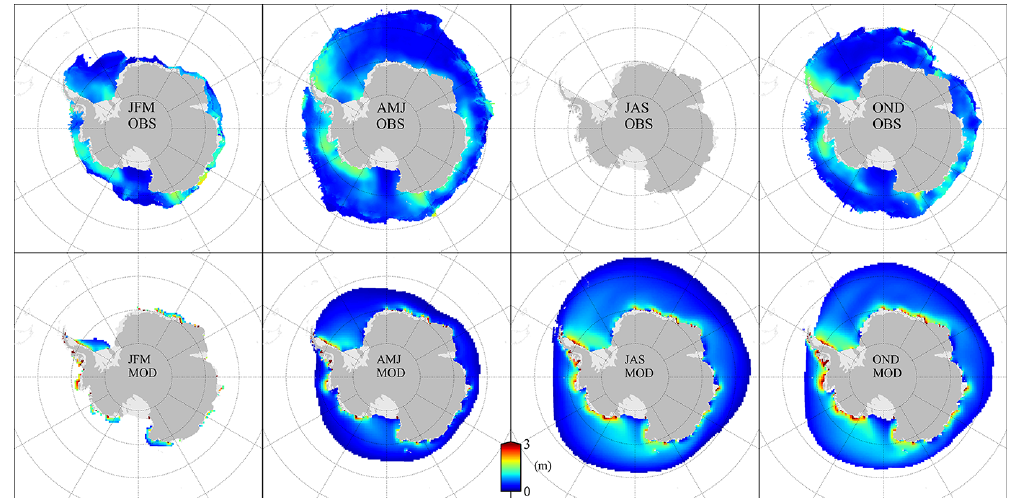
Fig. 7. Mean (1985–2011) seasonal modelled ice thickness (bottom row) compared to mean (2003–2008) seasonal observed ice thickness (top row). Ice thickness observations taken from ICESat measurements (Kurtz and Markus, 2012). Note that no observations were obtained during winter (JAS). Regions with a respective ice concentration less than 0.5 are masked in both data sets. JFM: January–March (summer), AMJ: April–June (autumn), JAS: July–September (winter), OND: October–December